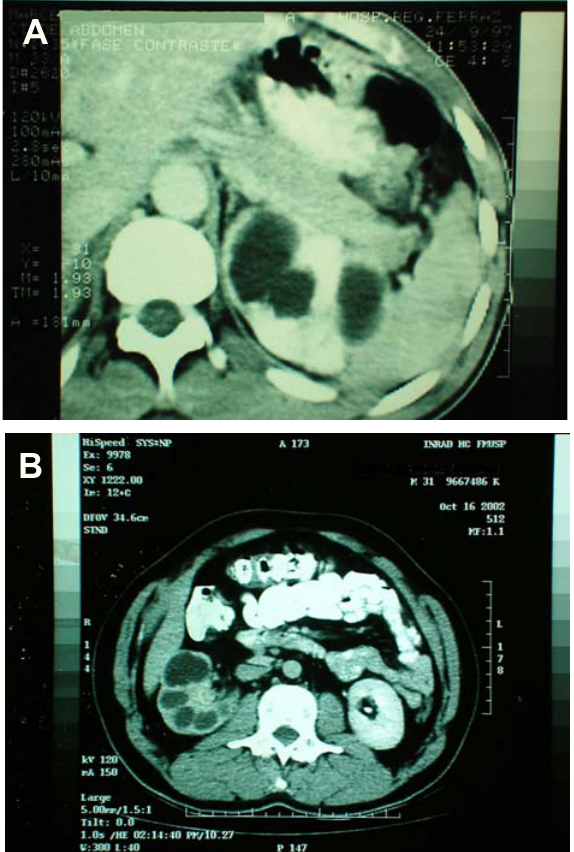
Figure 4 – A) and B) Computed tomography showing